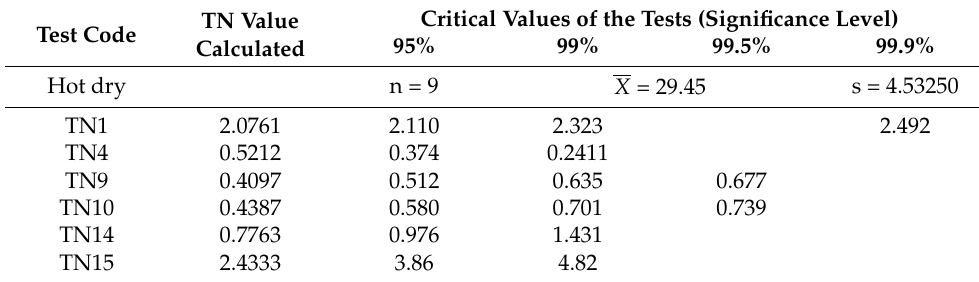
Table 7. Results of the discordance tests at equilibrium temperatures for a hot-dry